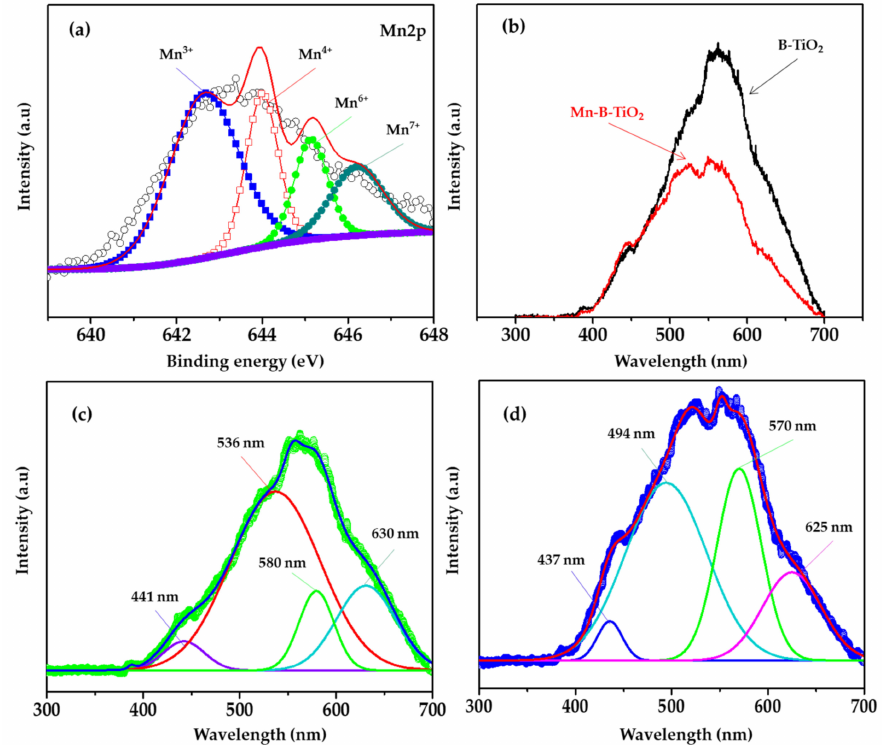
Figure 6. ( a ) Mn2p XPS spectra of Mn-B-TiO 2 NPs, ( b ) PL spectra, and ( c ) deconvoluted PL spectra of B-TiO 2 and ( d ) Mn-B-TiO 2